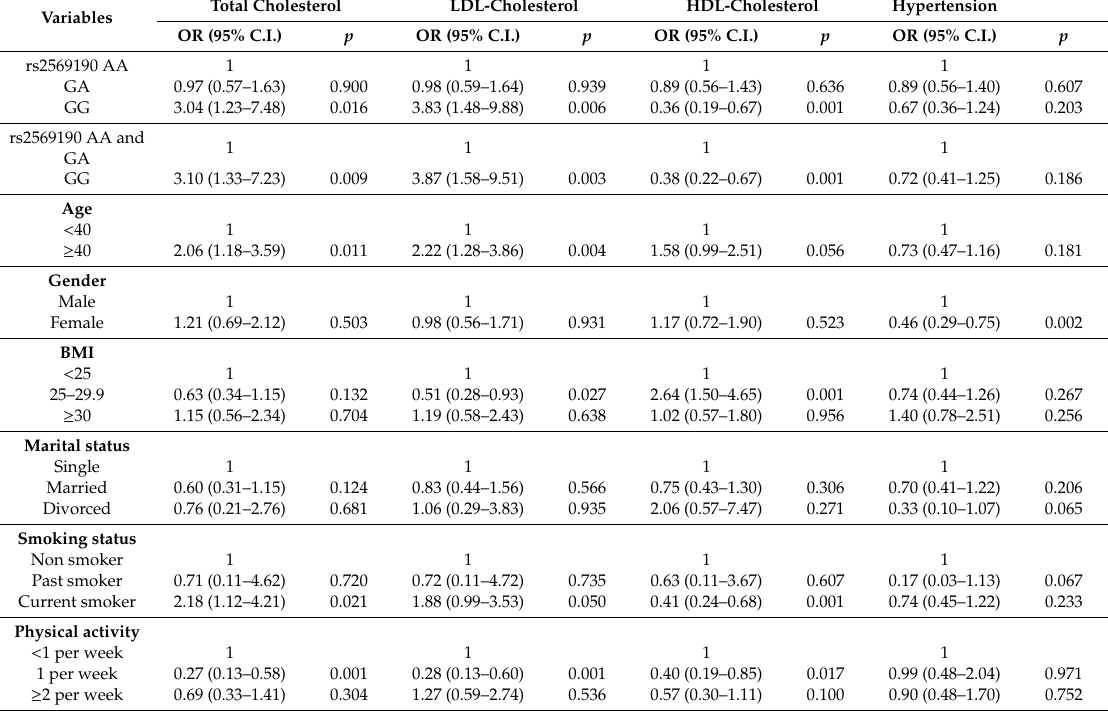
Table 3. Multiple logistic regression analysis with hyperlipidemia and